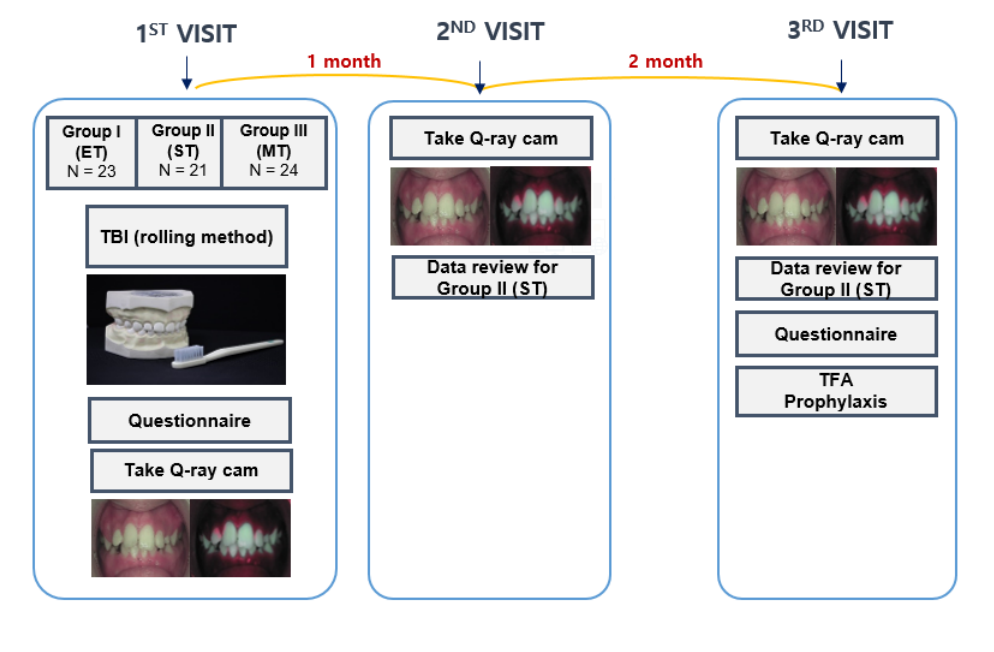
Figure 6. Graphic diagram of this study. ET: electro toothbrush; ST: smart toothbrush; MT: manual toothbrush; TBI: tooth brush instruction; TFA: topical fluoride